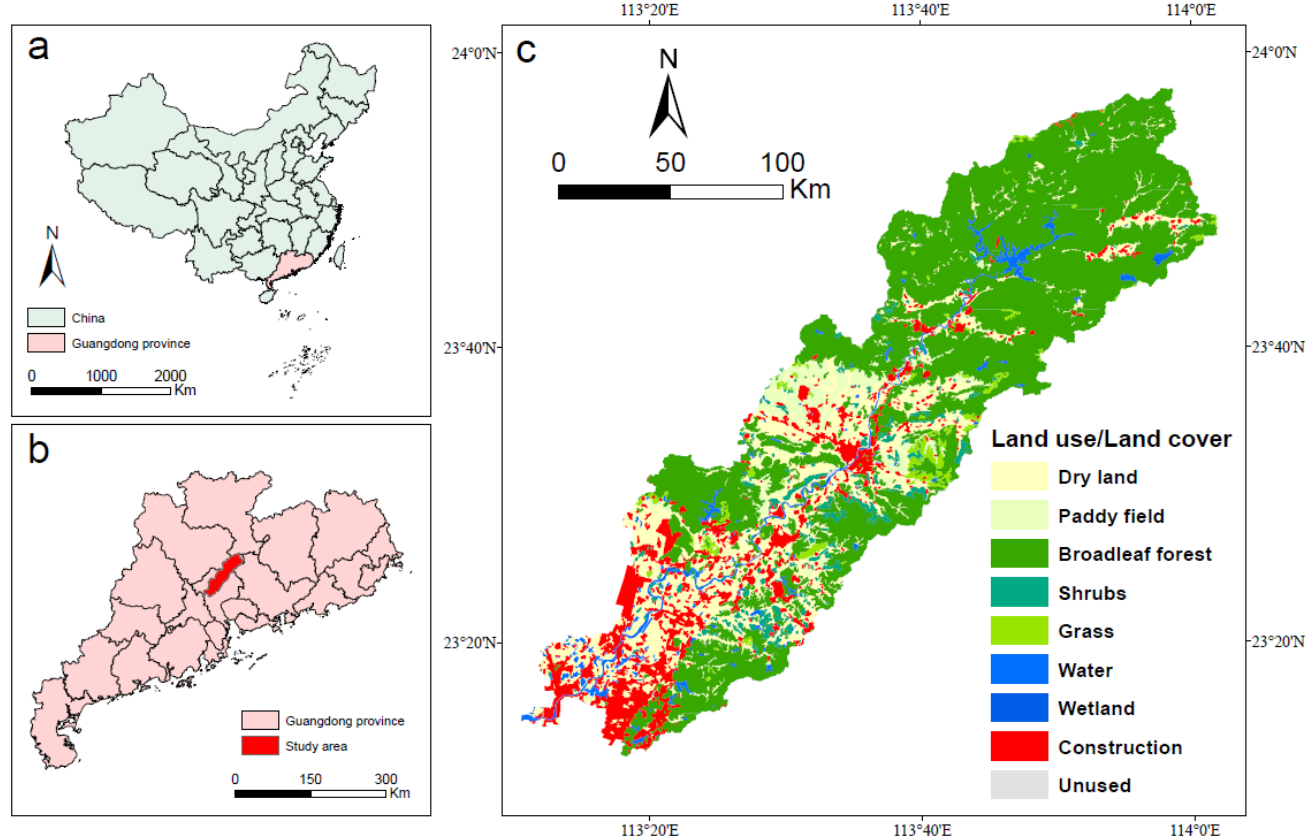
Figure 1. Location map of the study area: ( a ) the location of Guangdong Province in China; ( b ) the location of Liuxi River Basin in Guangdong Province; ( c ) the Land use/cover of the study area. Table 1. Data source and